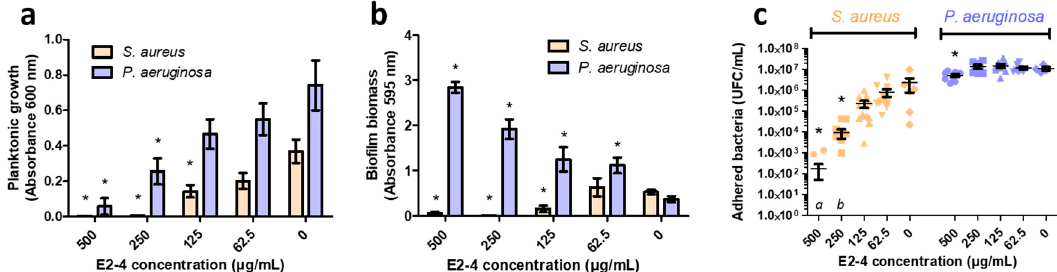
Figure 1. Antibiofilm activity of Prunus avium bark extract (E2-4) against S. aureus and P. aeruginosa , after 24h of contact. ( a ) Evaluation of the planktonic growth of bacteria through optical density measurement at 600 nm. ( b ) Evaluation of the total biofilm biomass through crystal violet coloration and absorbance measurement at 595 nm. ( c ) Concentration of bacteria adhered on coverslips, after ultrasonication and culture on agar plates. * indicates a significant difference ( P < 0.05) between the condition and the control without E2-4 (0 µg/mL). a : 11 replicates did not present any adhered bacteria. b : 6 replicates did not present any adhered bacteria.